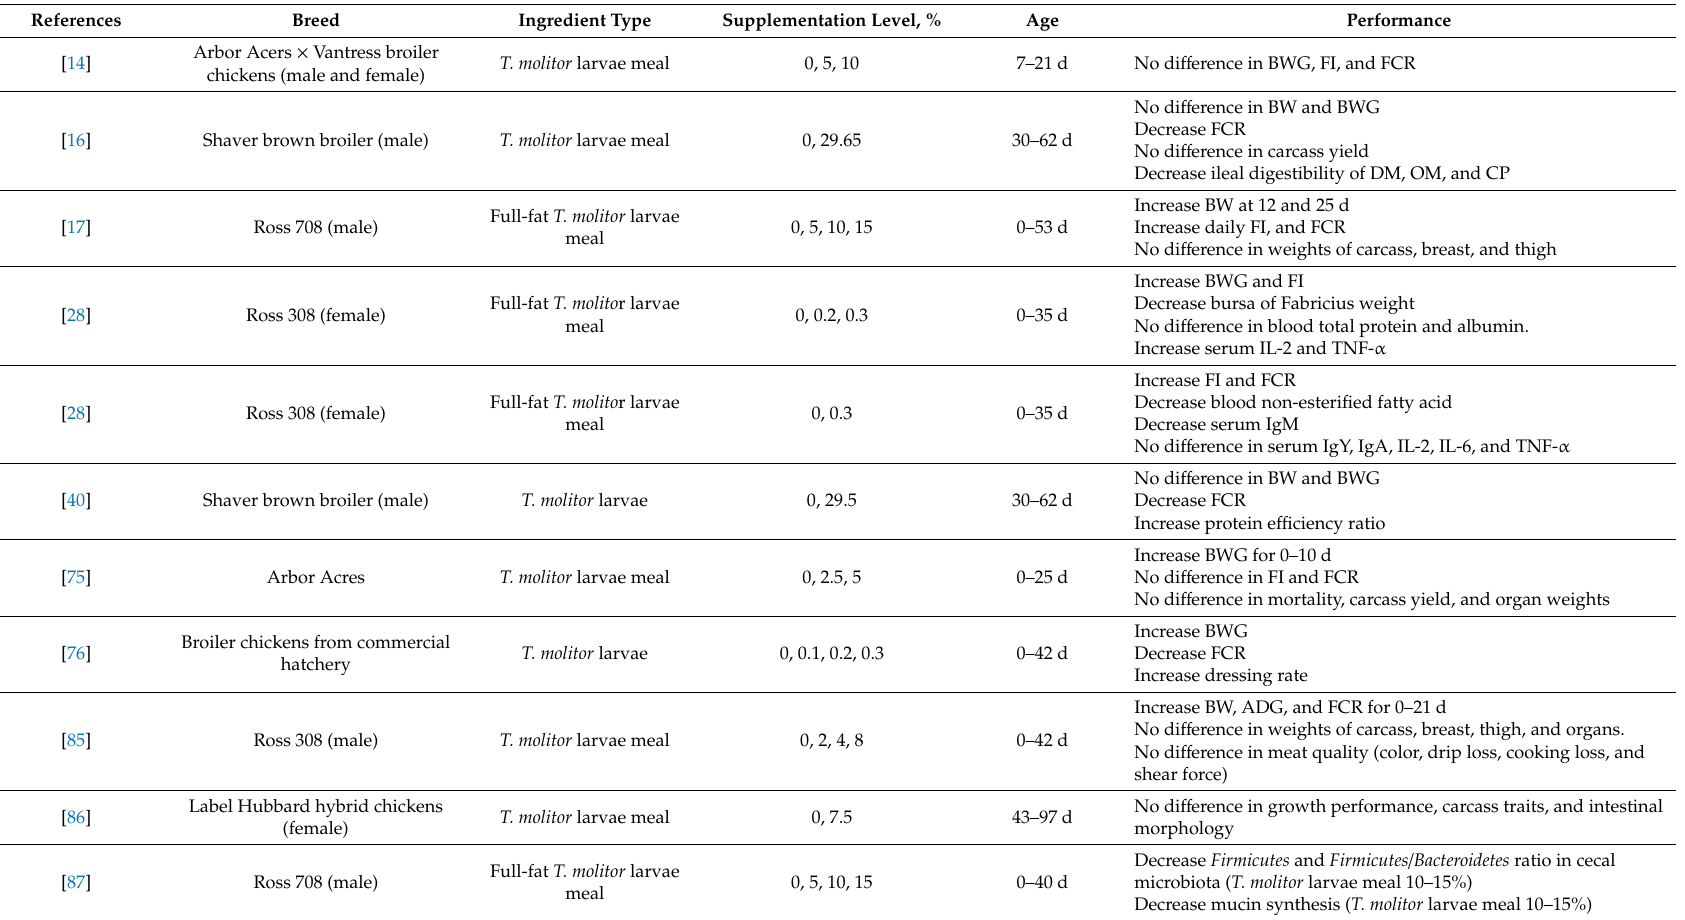
Table 5. E ff ects of Tenebrio molitor larvae or larvae meal supplementation on broiler